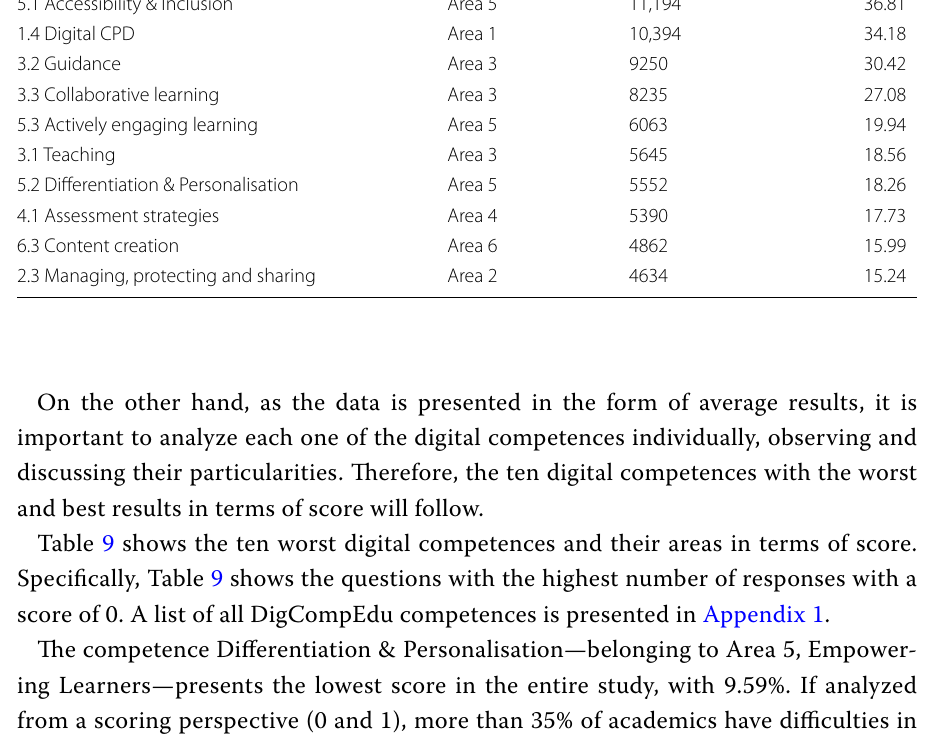
Table 10 The ten digital competencies with the highest number of lecturers who scored 4 Competence